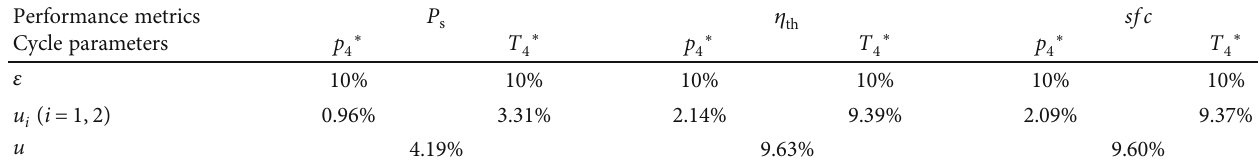
Table 1: Uncertainty analysis of the performance metrics of the rotating detonation-based turboshaft